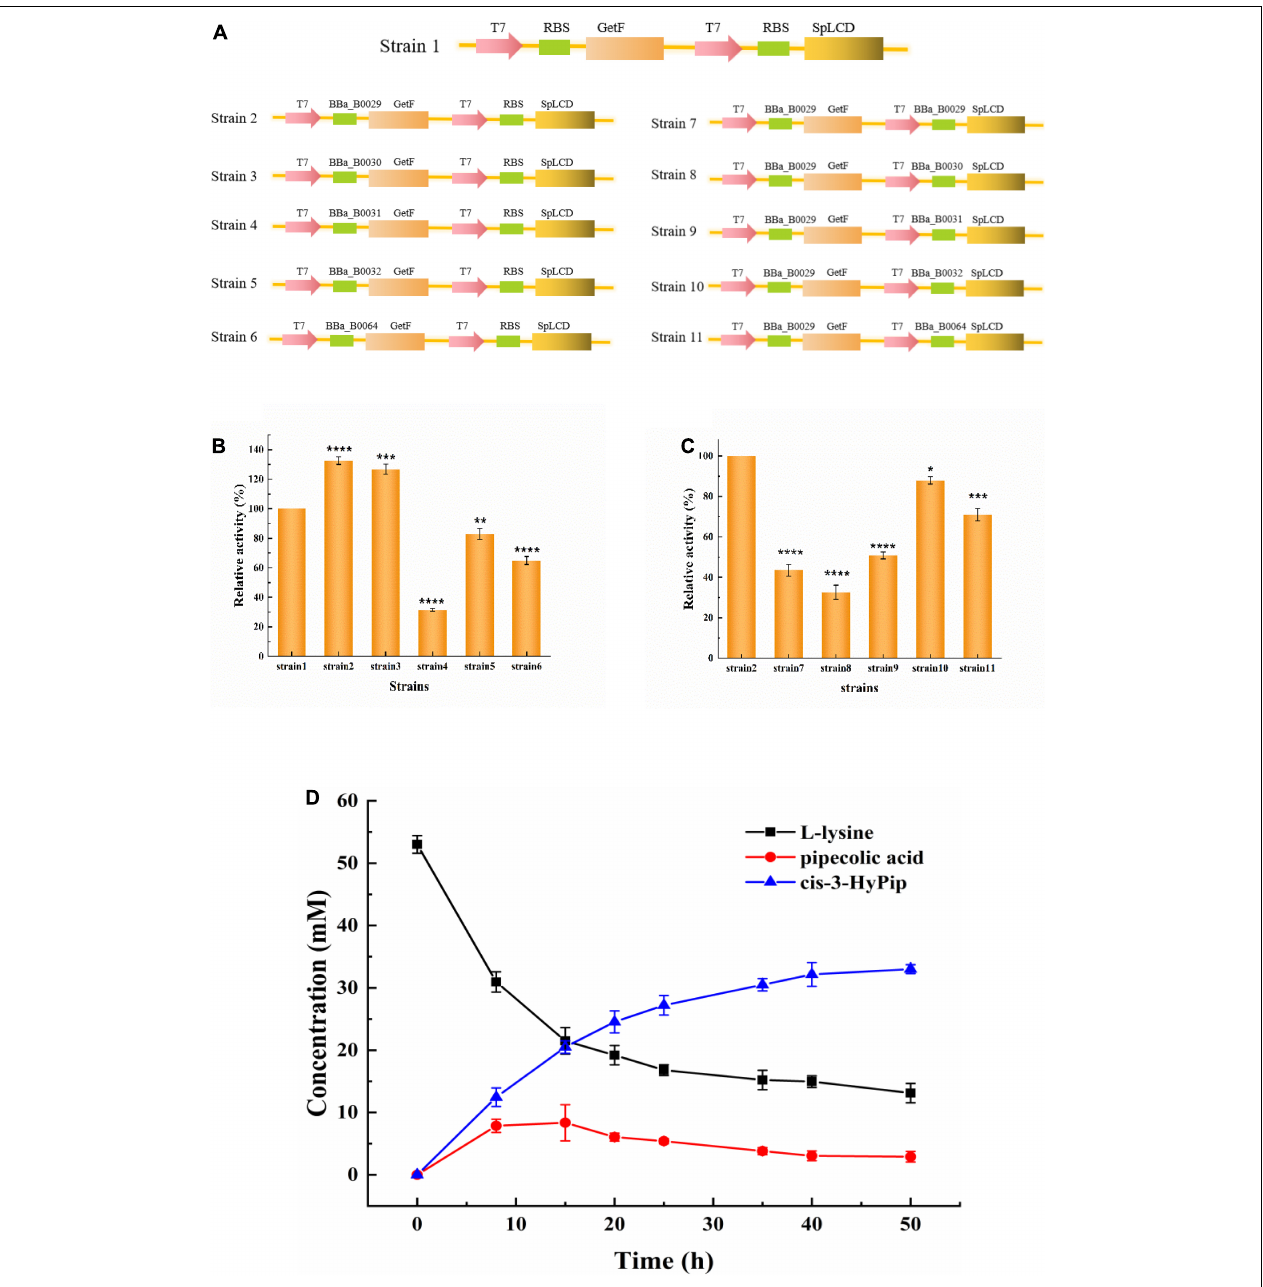
FIGURE 2 | Whole-cell catalysis effects of strains with different RBS strengths. (A) Construction of different strains. (B) The effect of GetF RBS translation strength on catalysis. (C) The effect of SpLCD RBS translation strength on catalysis. (D) Time course of the bioconversion by the strain 2 (containing pETduet-1-29- getf -RBS- splcd ). * P < 0.05, ** P < 0.01, *** P < 0.001, **** P <